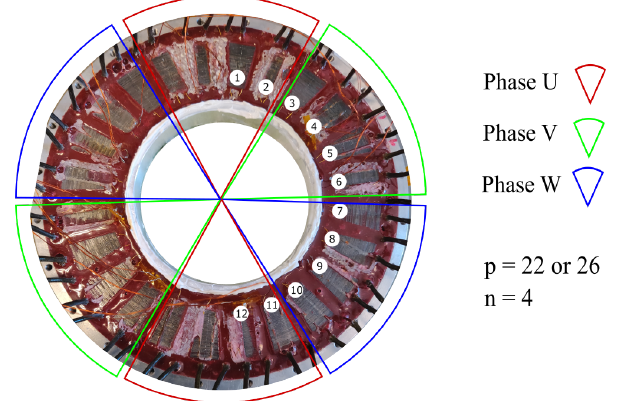
Figure 10. Indication of the PT100 temperature sensor